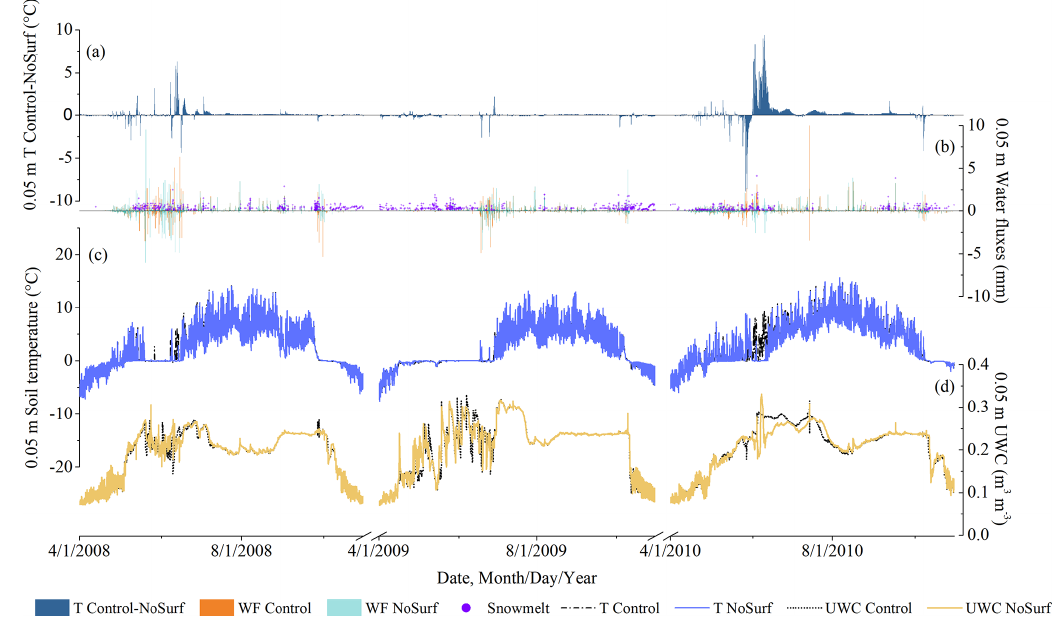
Figure 6. Hourly soil temperature, water flux, and UWC at 0.05m depth, representative of shallow depths, simulated under NoSurf and Control during the 2008–2010 thaw periods. From top to bottom are as follows: (a) the differences in soil temperature ( T ) between Control and NoSurf (Control–NoSurf), with positive values indicating heating effects and negative values indicating cooling effects; (b) snowmelt water simulated under Control and the water fluxes (WFs) at 0.05m simulated under NoSurf and Control, in which positive values represent downward flows and negative values upward flows; and (c) soil temperatures and (d) UWCs simulated under NoSurf and Control.